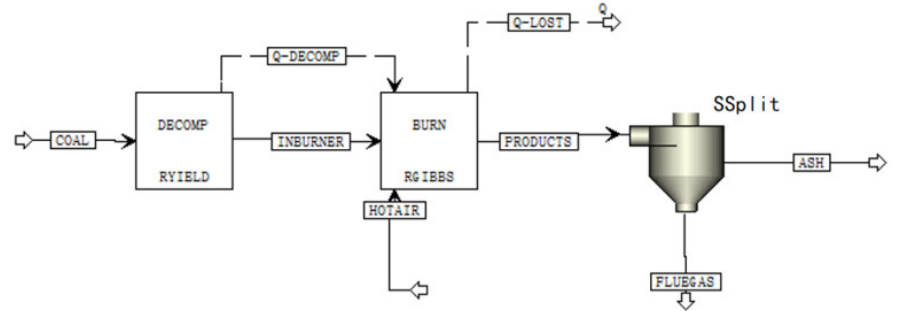
Figure 5. Combustion system module.